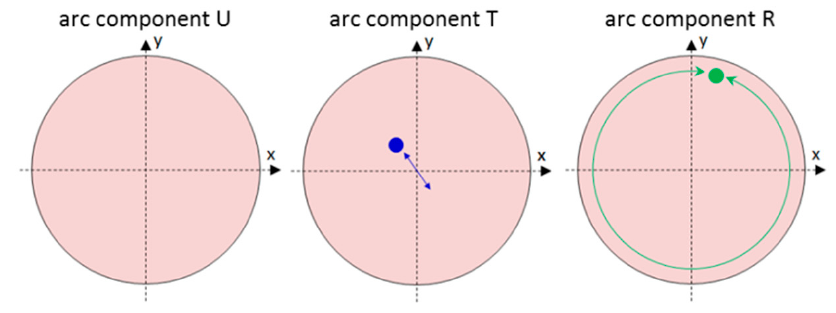
Figure 4. Schematic of the three individual elementary arc distributions.